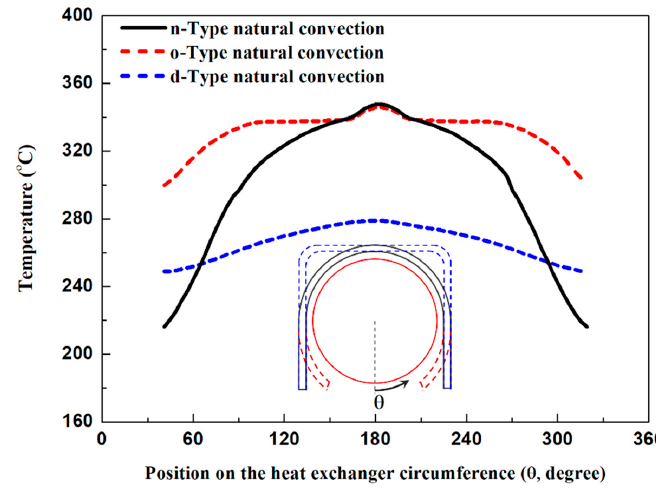
Figure 7. Surface temperature distribution along the heat exchanger circumference.